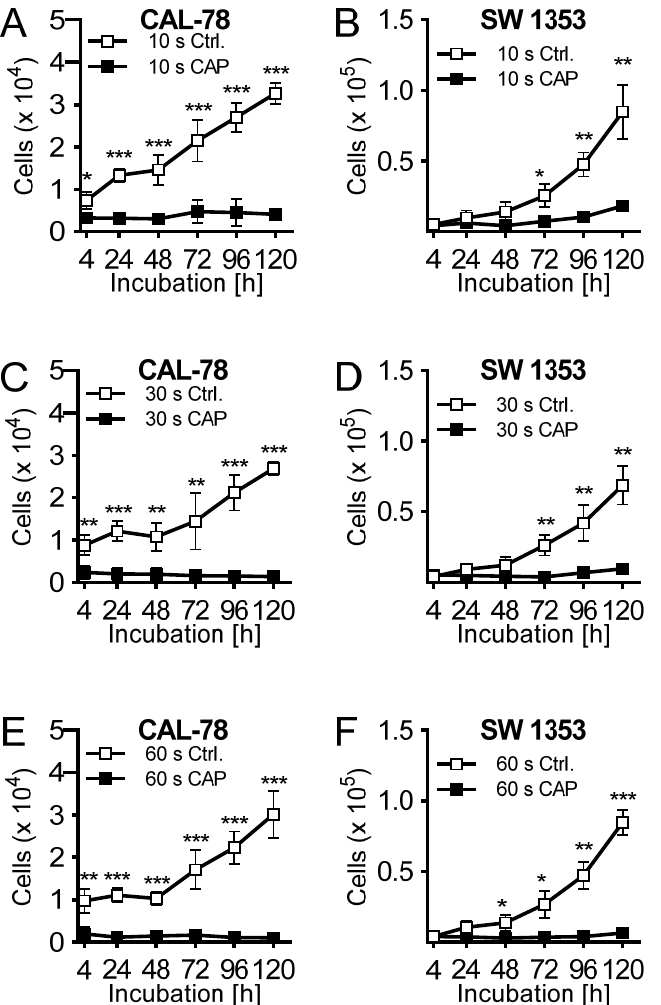
Figure 1. The human chondrosarcoma cell lines CAL-78 ( A , C , E ) and SW 1353 ( B , D , F ) were treated with 10 ( A + B ), 30 ( C + D ), or 60 s ( E + F ) cold atmospheric plasma (CAP) or carrier gas argon with kINPen med (neoplas tools, Greifswald, Germany). Living cells were counted with CASY Cell Counter and Analyzer (OLS, Bremen German) 4, 24, 48, 72, 96, and 120 h after exposure. Data are given as mean ± SD; significant differences are indicated as follows: * p ≤ 0.05, ** p ≤ 0.01, *** p ≤ 0.001. Cell culture medium was treated for 10, 30, and 60 s, and immediately applied to untreated CS cells seeded 24 h before. Cell culture medium activated with CAP for 10 s exhibited a rather modest antiproliferative effect after 120 h of incubation (CAL-78: 63 ± 7 %, p = 0.002; SW 1353: 24 ± 6 %, p < 0.001; Figure 2A,B). This was more pronounced when the cell culture medium was activated for 30 s (Figure 2C,D) and finally achieved a similarly strong effect after 60 s of activation as in the direct CAP treatment of the cells (Figure 2E,F).